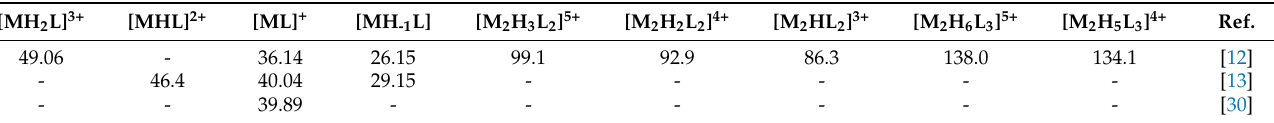
Table 6. Overall complex-formation constants (log β ) of DFOB with Zr(IV), under different experimental